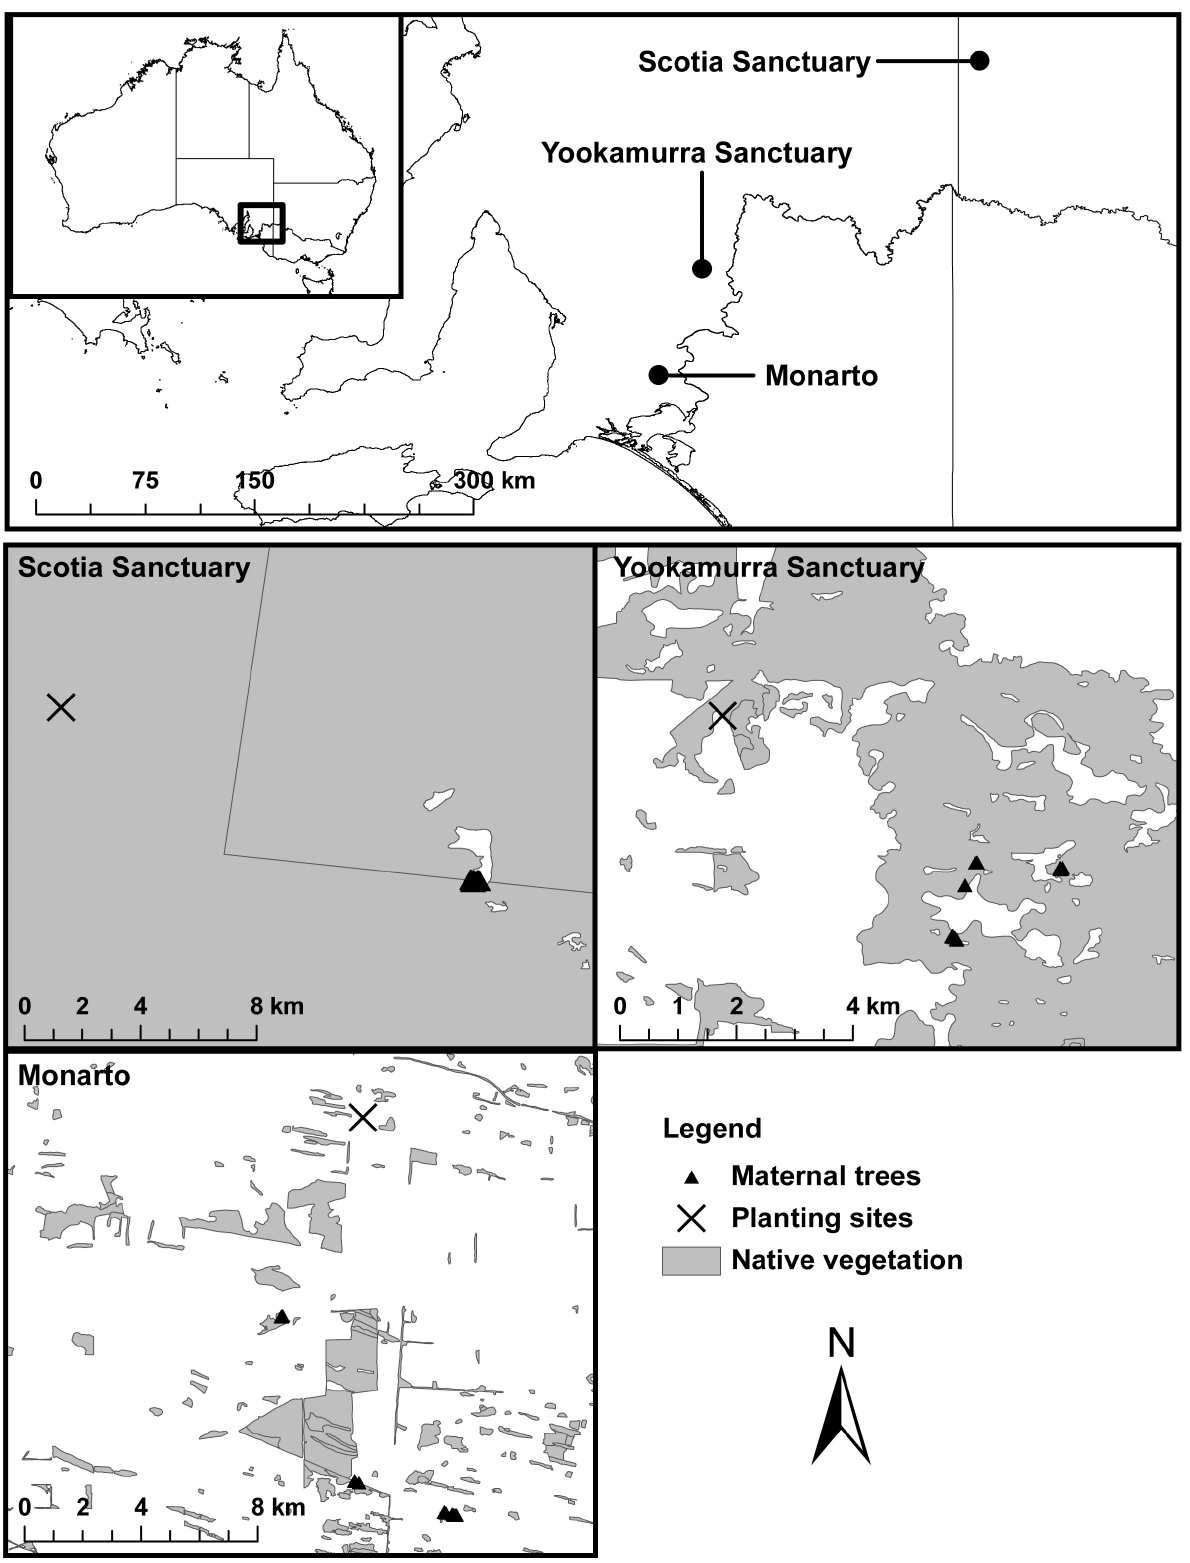
Figure 1. Map showing location of Eucalyptusgracilis maternal trees and planting sites. Maps show samples from the three populations in the Murray Darling Basin, Australia. Insert maps show greater spatial information on sampled populations. Reciprocal transplant planting locations shown at each planting site by a cross (x).